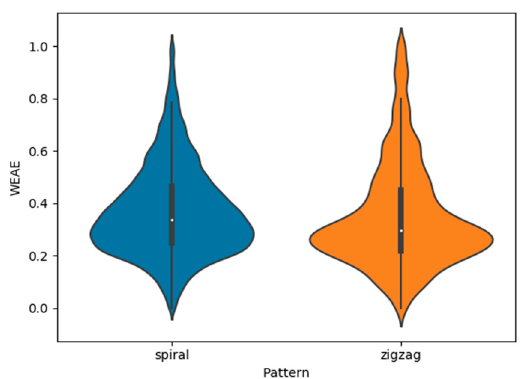
Figure 5. Density distribution of normalized NO 2 outputs with flight pattern as the only discriminating factor, illustrated by a violin plot.